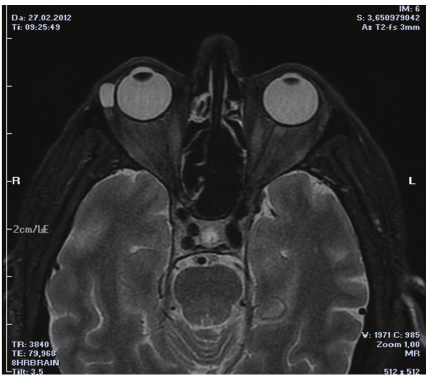
Figure 1: Magnetic resonance image of dacryops.